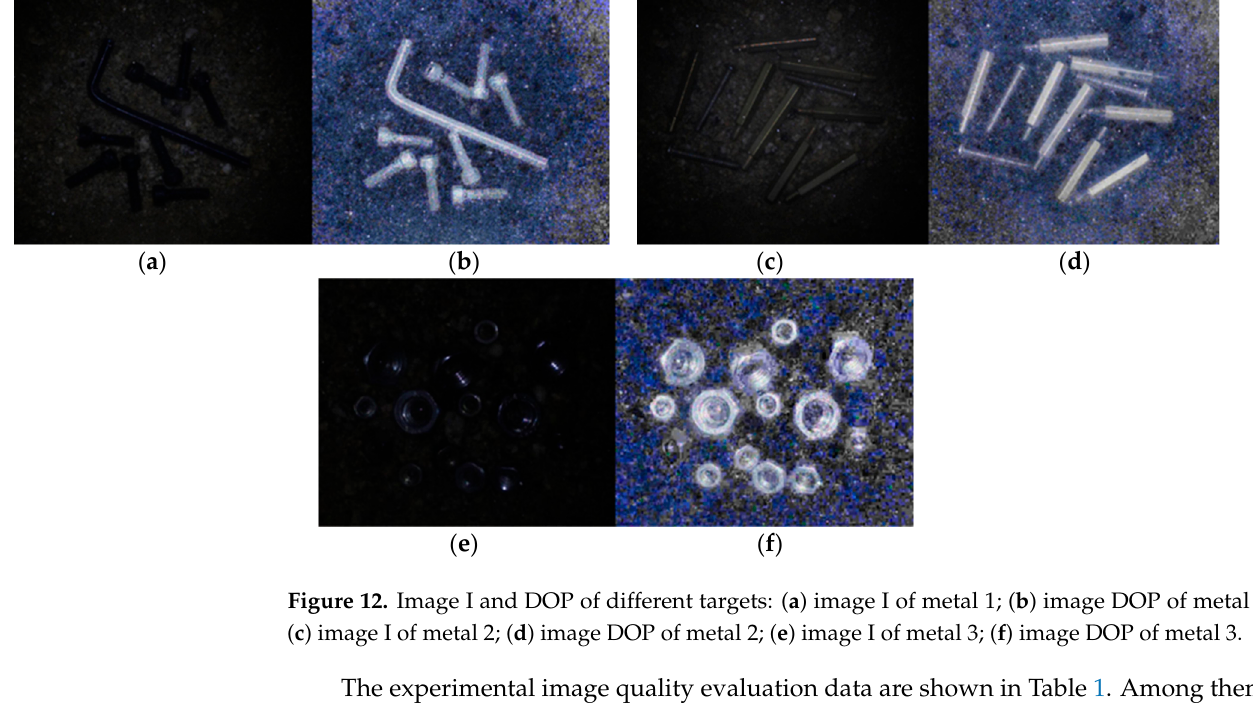
Figure 11. Physical figure of metal target.